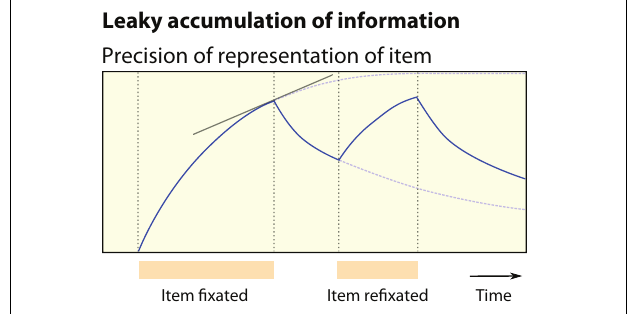
FIGURE 1 | Foraging for information. We test the view that foraging for information involves the leaky accumulation of information about the fixated item. Information acquisition involves a time-dependent, location-specific gain in precision . Participants should leave a location when the information gain rate falls below a threshold, in parallel with classical foraging for reward (Stephens and Krebs, 1987). The location fixated next is determined by which location has the greatest estimated information gain rate. Meanwhile information about the original item decays . This predicts that participants refixate the first item seen, that dwell times shorten over the course of a trial, and that longer fixations result in fewer subsequent refixations of the same